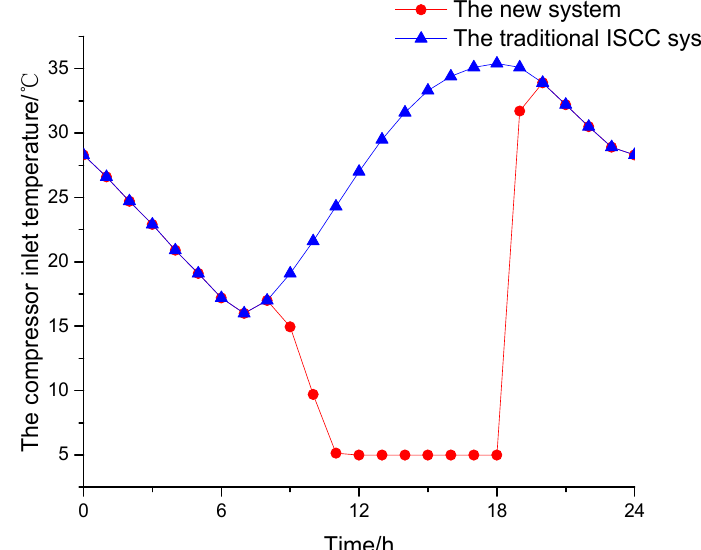
Figure 10. Compressor air inlet temperature change of the traditional ISCC and the new system in a typical summer day.